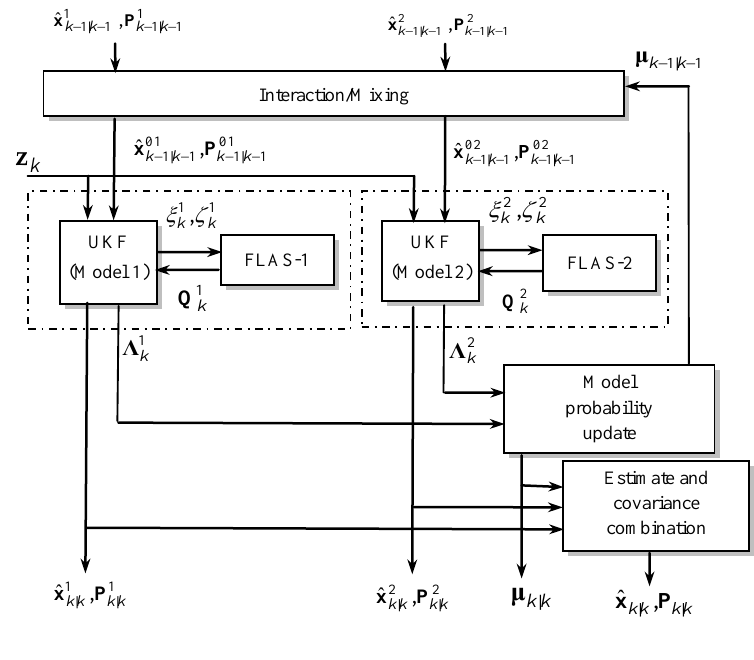
Figure 1. The block diagram of the FUZZY-IMMUKF algorithm. (one cycle with two